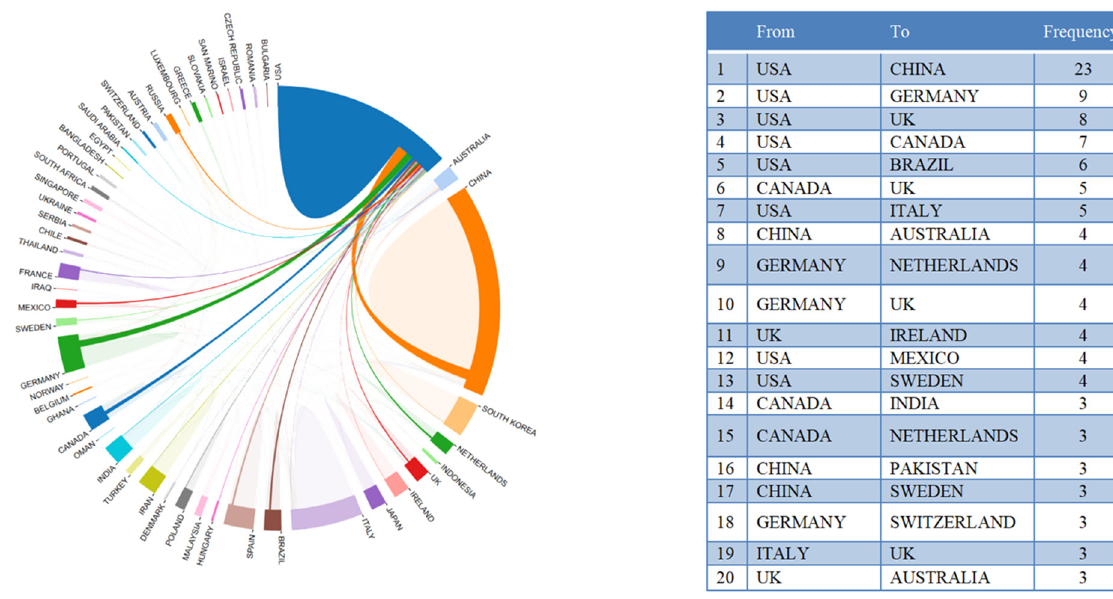
Figure 4. International collaboration analysis and the top 20 collaborations between countries.